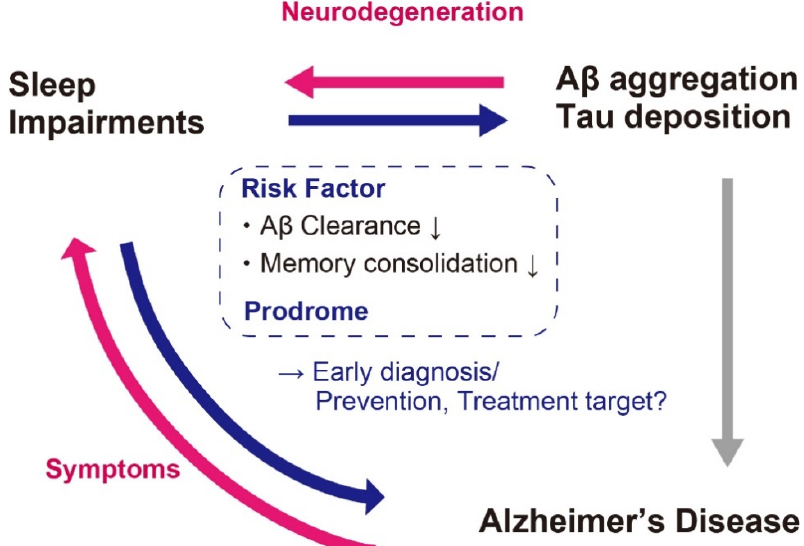
Figure 3. Association between sleep impairments and AD. Sleep impairments occurs not only as associated symptoms but also as prodrome. Moreover, sleep impairments can be a risk factor of A β aggregation and AD. It is therefore a promising candidate for the biomarker for early diagnosis and prevention or treatment target of AD.